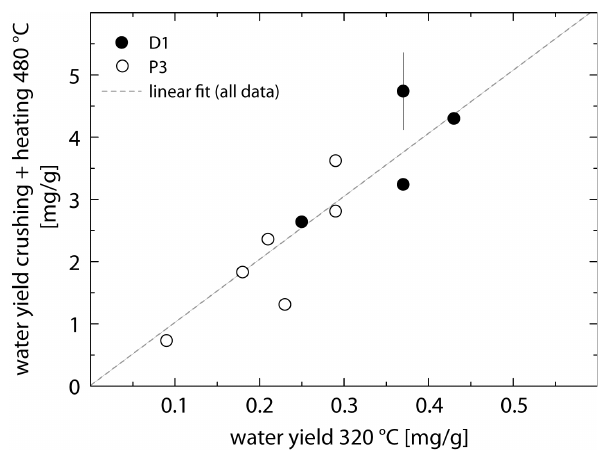
Fig. 3. Comparison of water yields from selected samples of stalag- mites P3 and D1 resulting from two different extraction techniques. For the 320 ◦ C extractions, water is released from externally pre- crushed stalagmite grain size separates that are subsequently heated to 320 ◦ C. For the 480 ◦ C extractions, samples are vacuum-crushed and subsequently heated to 480 ◦ C. The resulting water yields are linearly correlated (coefficient of determination r 2 = 0.97). The one sigma uncertainties of water yield determinations are, with one ex- ception, smaller than the symbol